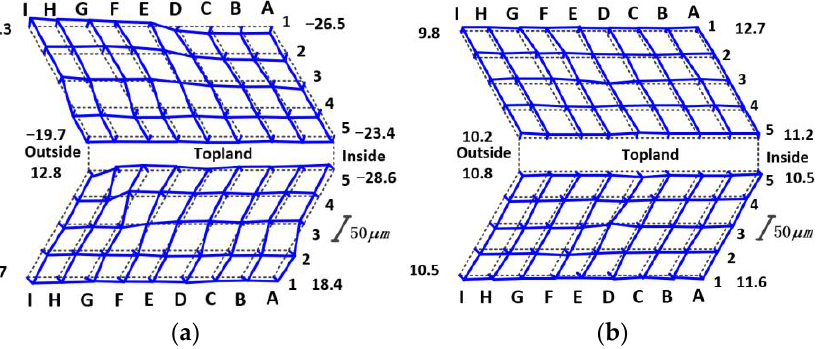
Figure 15. Schematic diagram of tooth-surface deviation: ( a ) Hard-honing tooth surface; ( b ) Flexible- honing tooth surface.